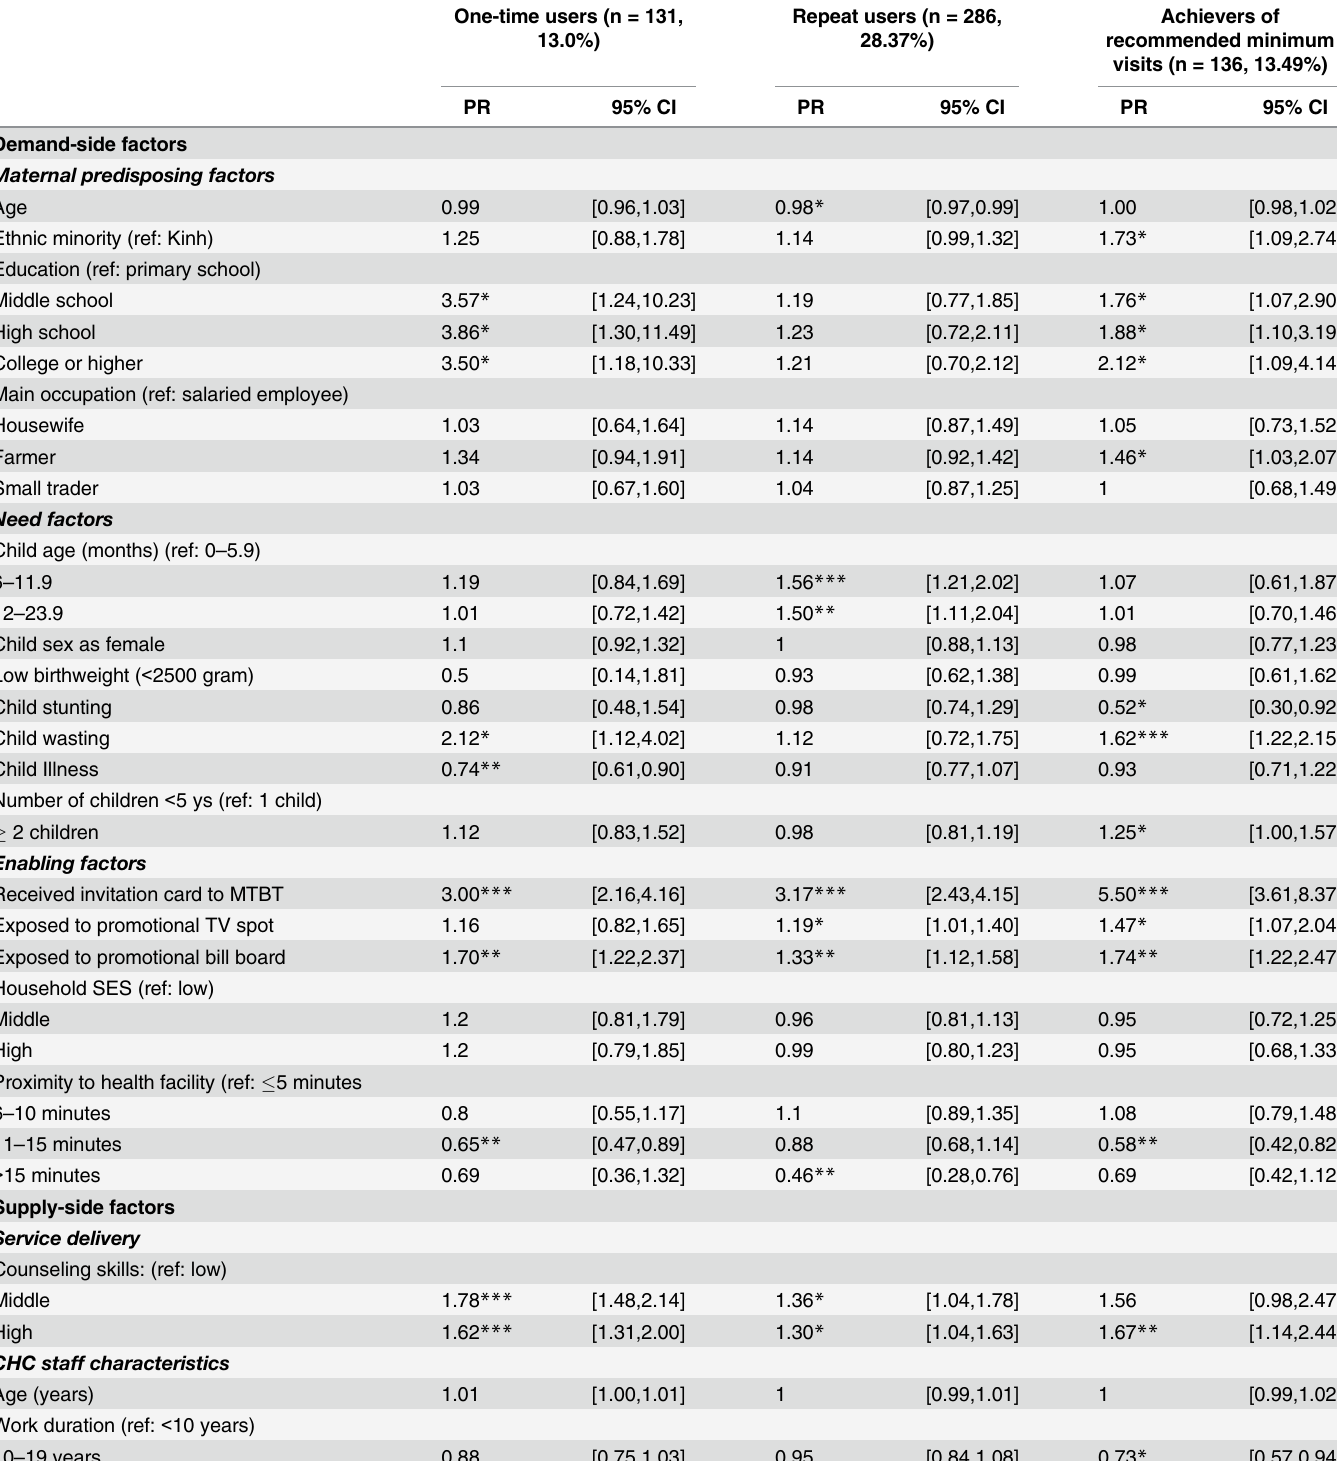
Table 2. Associations between demand- and supply-side factors and categories of IYCF counseling services utilization (groups of MTBT users), compared to never